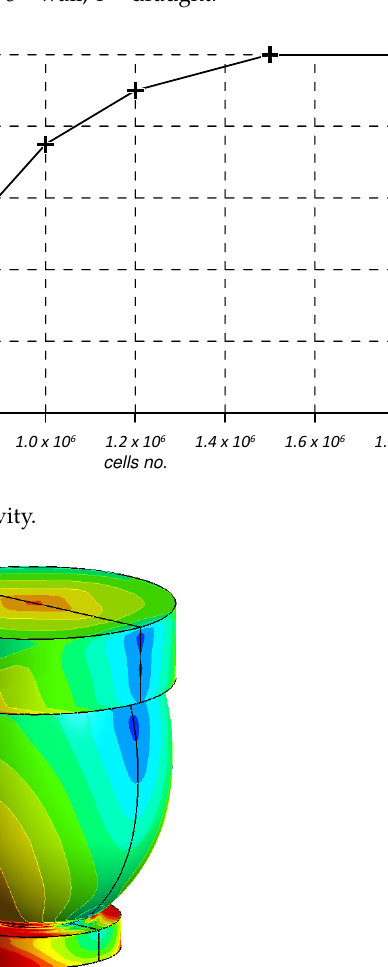
Figure 5. CFD model: 1—pressure inlet (open channel), 2—pressure outlet, 3—symmetry, 4—pressure outlet (open channel), 5—wall, T —draught.